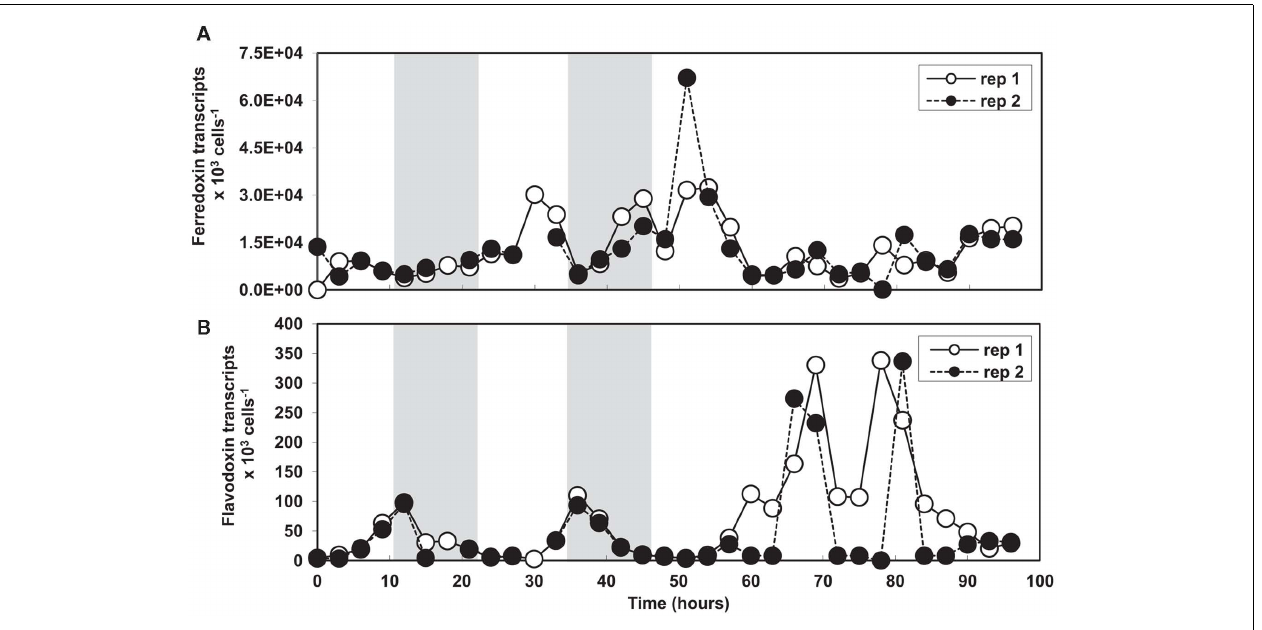
continuous light. Results from culture replicate 1 are shown in white and replicate 2 results are shown in black. Data points not connected in replicate 2 represent missing time points. Shaded boxes indicate the dark period.